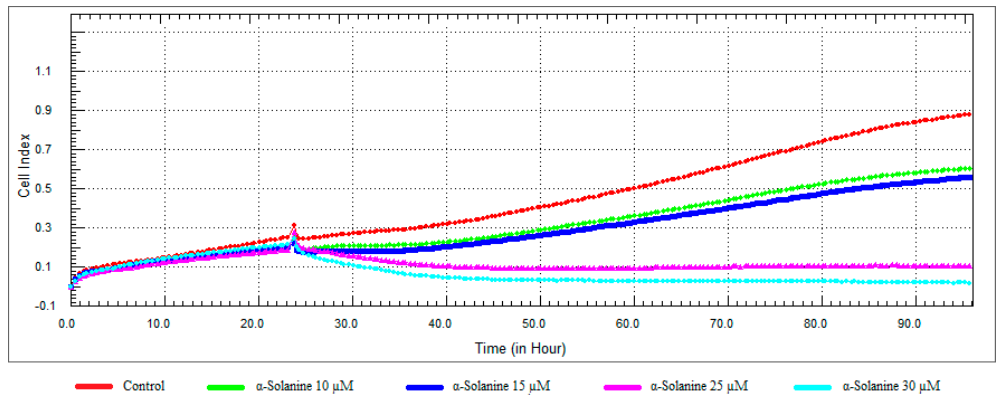
Figure 8. Dose and time-dependent cytotoxic effect and alteration of CI of α -solanine determined by xCELLigence system: Effect of α -solanine on proliferation of RL95-2 cell. Cells were treated with various concentrations of α -solanine for 72 h. The CI was calculated from four repeated measurements.